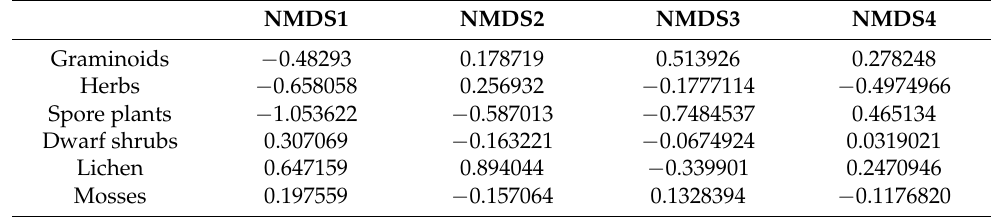
Table A4. Species group scores.